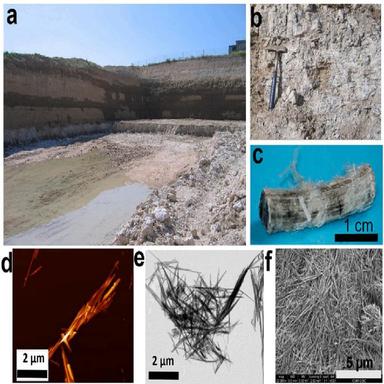
a) Deposit of sepiolite located in the Tagus Basin (Toledo-Madrid region, Spain), where the mineral is distinguished in the lower white stripe, which has been partially removed for exploitation (Photo by Santiago Leguey & Jos´e Casas). b) Detail of the sepiolite layer showing some extracted rocks (Photo by Santiago Leguey & Jos´e Casas). c) Morphological aspect of macroscopic fibers of sepiolite from Ampandrandava, Madagascar (Photo by Cristina Ruiz-Garcia). d-f) Morphology of sepiolite (disaggregated by ul